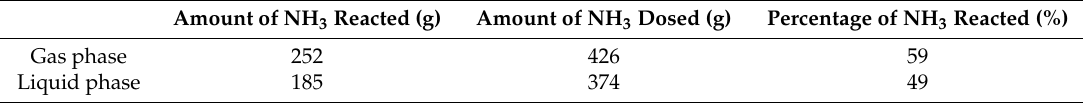
Table 2. Ammonia-mass calculations for standard and gaseous urea dosing at α = 1.0.